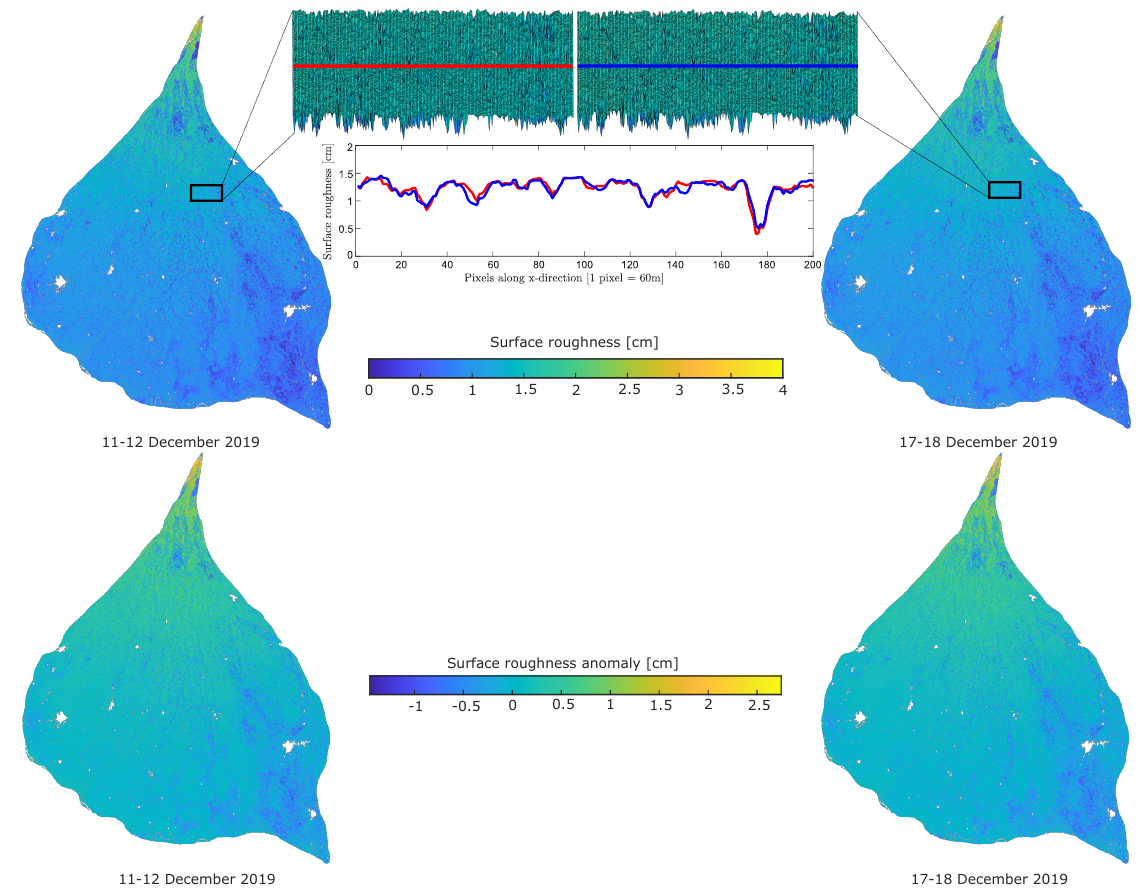
Figure 11. Spatial distribution of surface roughness predicted from PCA-MM-SVR ( top ) and the corresponding anomaly ( bottom ). The anomaly is calculated by subtracting the surface roughness at each pixel with the mean surface roughness value of the entire fan. The pixels in white represent invalid regions.